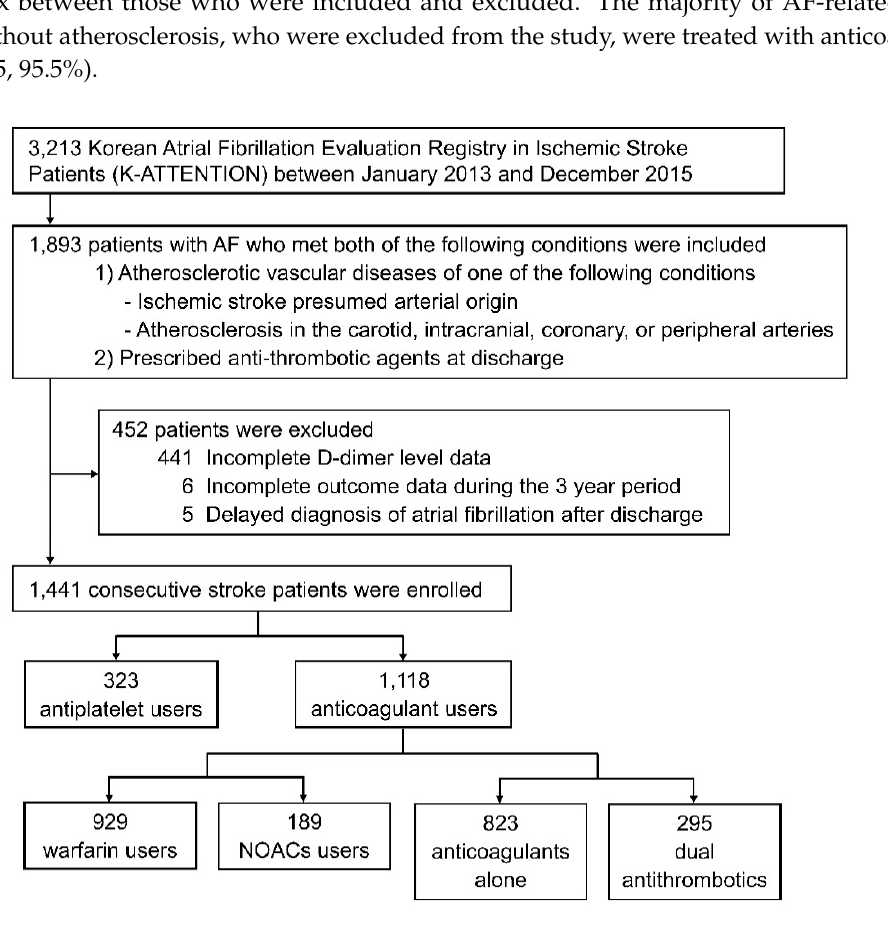
Figure 1. Flow chart of the study enrolment process.